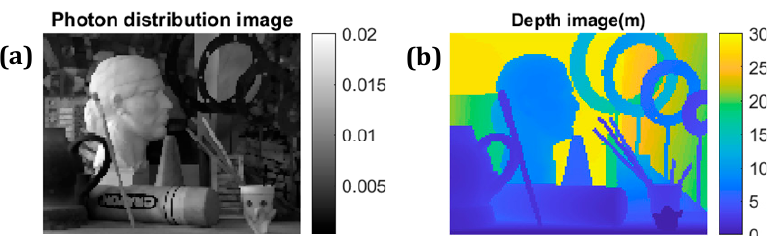
Figure 3. Middlebury dataset image for simulation. ( a ) Image of averaged signal photon per pulse; ( b ) depth image.